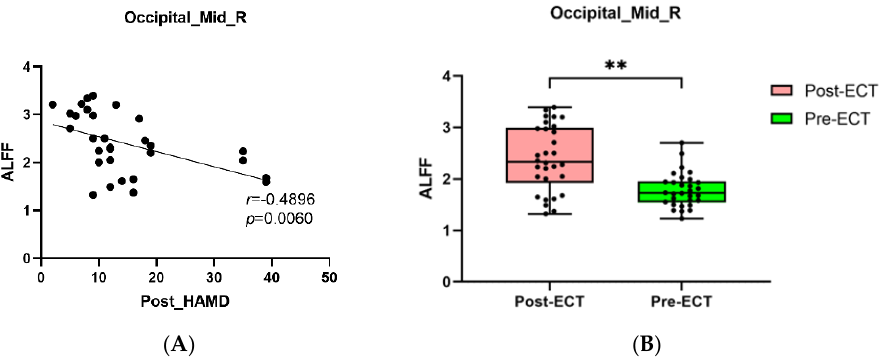
Figure 6. ( A ): The negative correlations between HAMD scores after ECT and ALFF in the Occipi- tal_Mid_R ( p = 0.0060). ( B ): MDDs showed increased ALFF in Occipital_Mid_R after ECT (** p < 0.01).